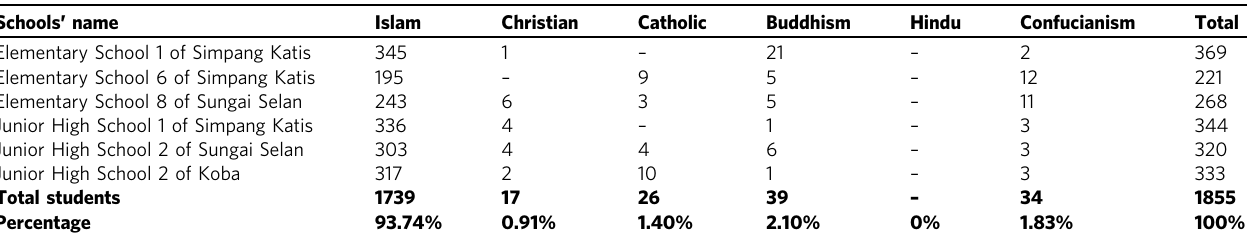
The bold values in the row percentage show the percentage of each religious students toward the total population.